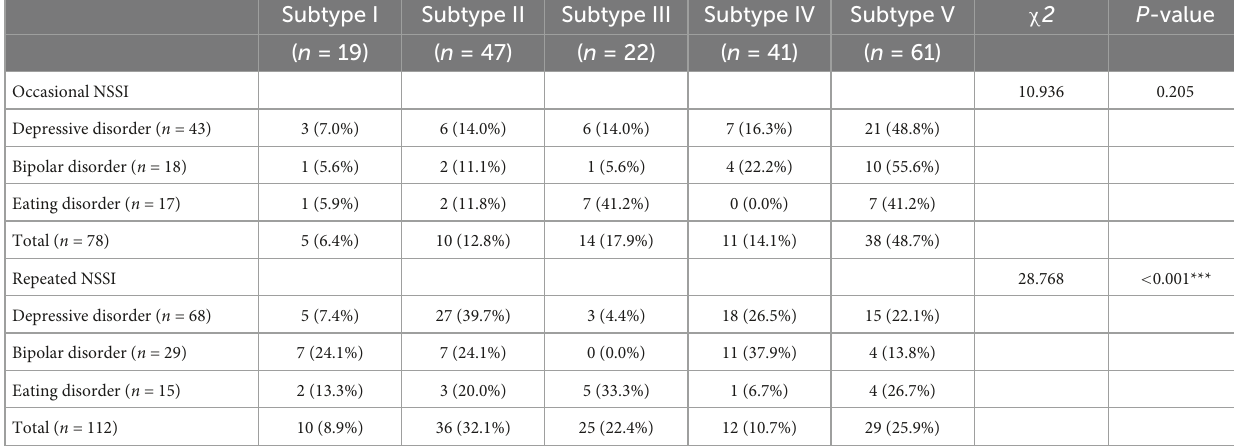
TABLE 3 The association between functional subtypes and diagnosis [ N